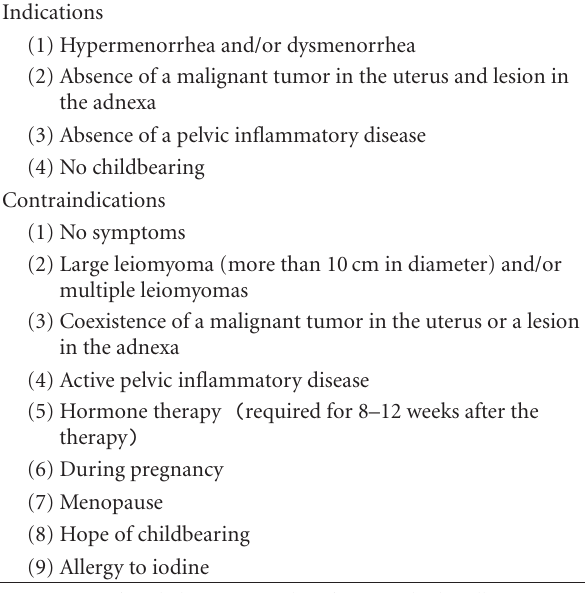
Table 2: General indications and contraindications of uterine artery embolization in patients with uterine leiomyomas.